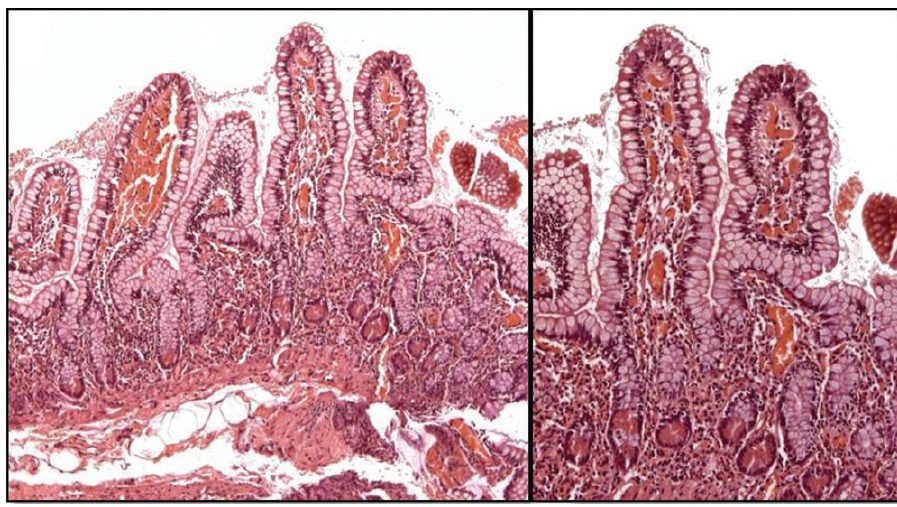
Figure 1 - Healthy ileal pouch mucosa, where villous: crypt ratio is 3 : 1. Presence of Paneth cells, ‘‘brush border’’ and less amount of goblet cells compared to